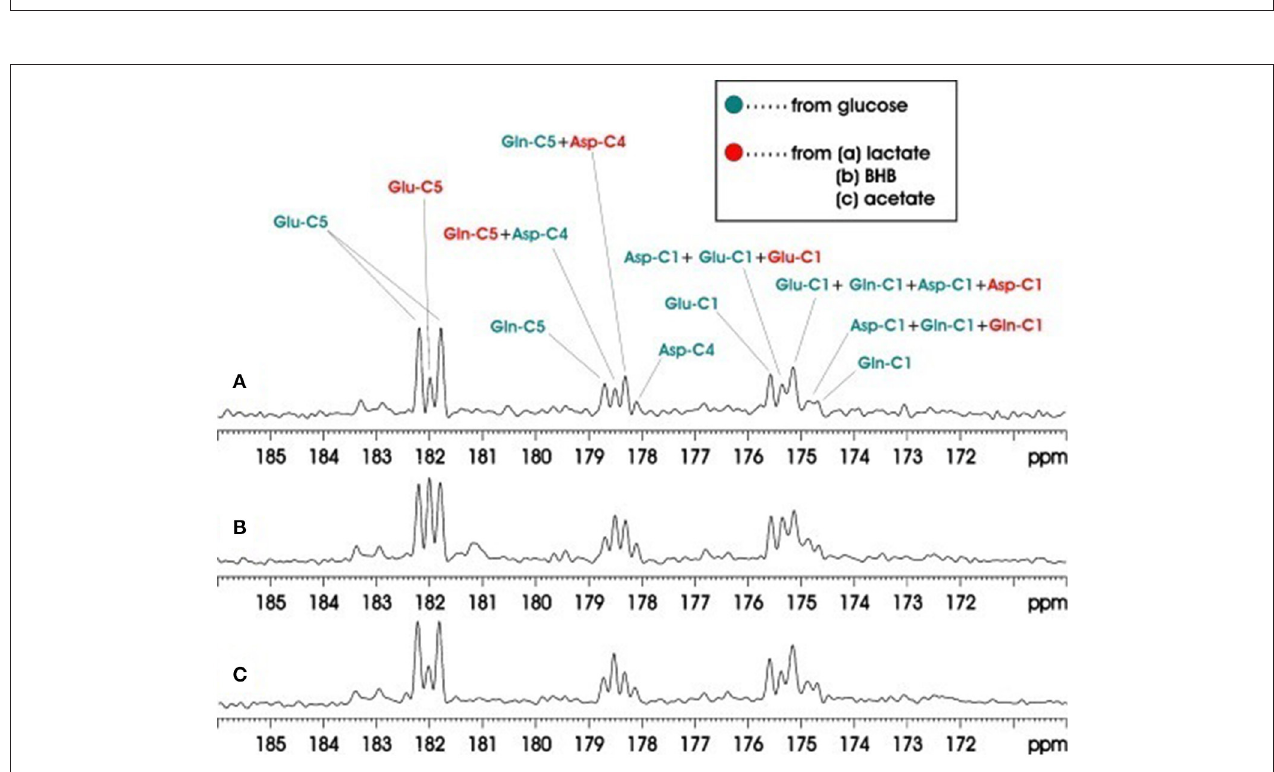
FIGURE 8 | Accumulated in vivo 13 C MRS spectra of intravenous co-infusions of [ 13 C 6 ]-d-glucose + [2- 13 C]lactate (A) , [ 13 C 6 ]-d-glucose + [1,3- 13 C 2 ]BHB (B), and [ 13 C 6 ]-d-glucose + [1- 13 C]acetate (C) . Each spectrum was averaged over the 0–180 min infusion period from an individual rat brain. Green: resonance lines originated from [ 13 C 6 ]-d-glucose; red: resonance lines originated from [2- 13 C] lactate. Adapted from Xiang et al. [31].